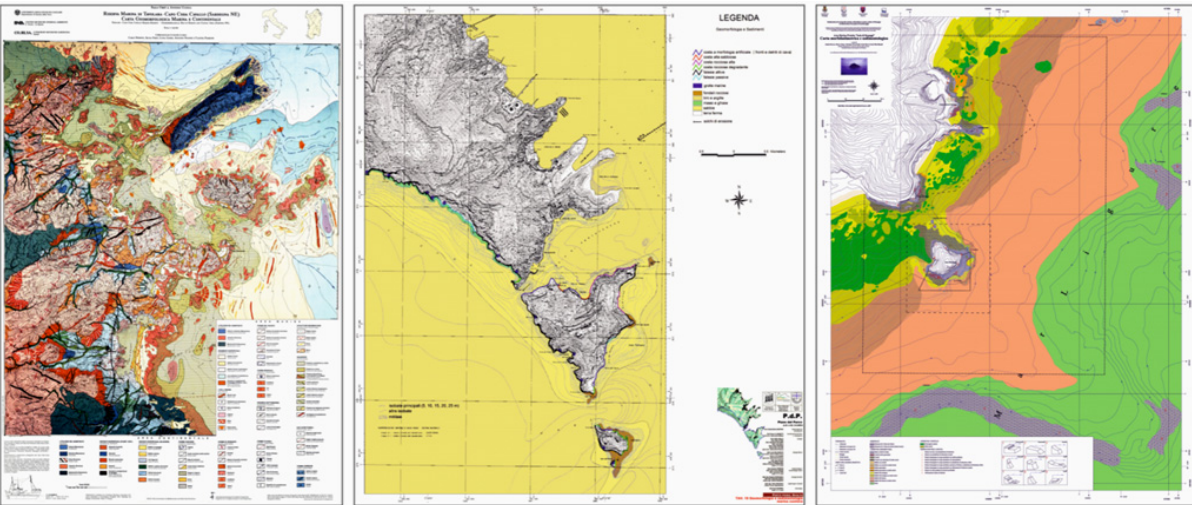
Figure 2. Reproduction at reduced scale of the morphobathymetric and sedimentological maps of the three MPAs considered. Left to right: “Tavolara-Punta Coda Cavallo” (original scale 1:25,000), “Arcipelago di Portovenere” (original scale 1:10,000), “Isola di Bergeggi” (original scale 1:2,000). These maps, at their full size, can be freely downloaded from the SEAMap site [45].